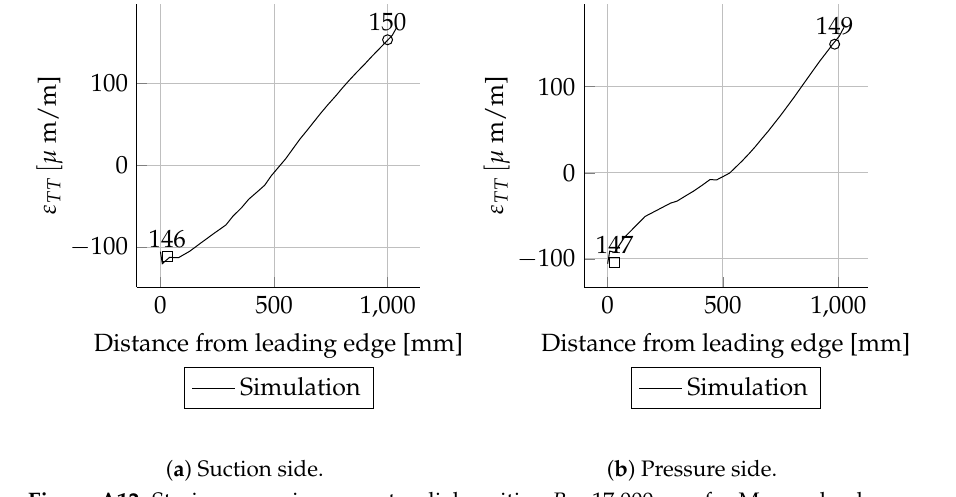
Figure A12. Strain comparison ε LL at radial position R = 17,000 mm for Mxmax load case.